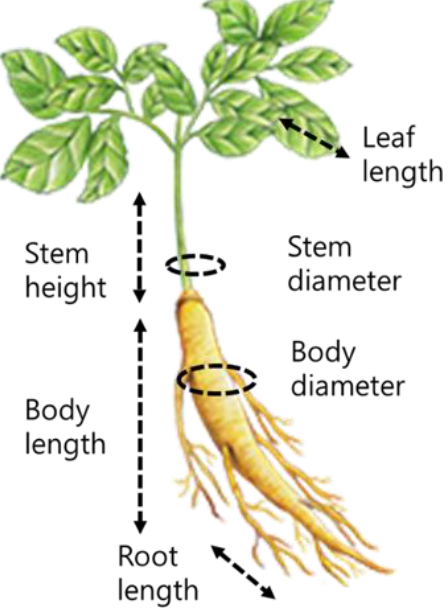
Figure 1. The coordinates of the experiment with view of the experimental site.